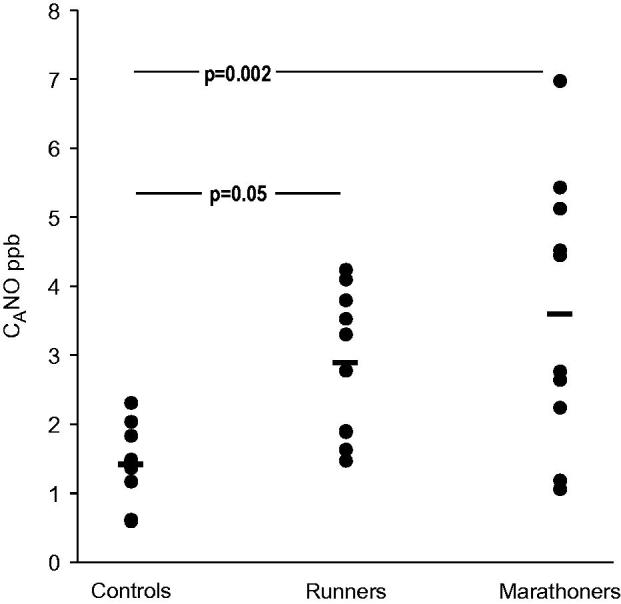
Alveolar nitric oxide (CANO) in controls, amateur runners, and marathoners.